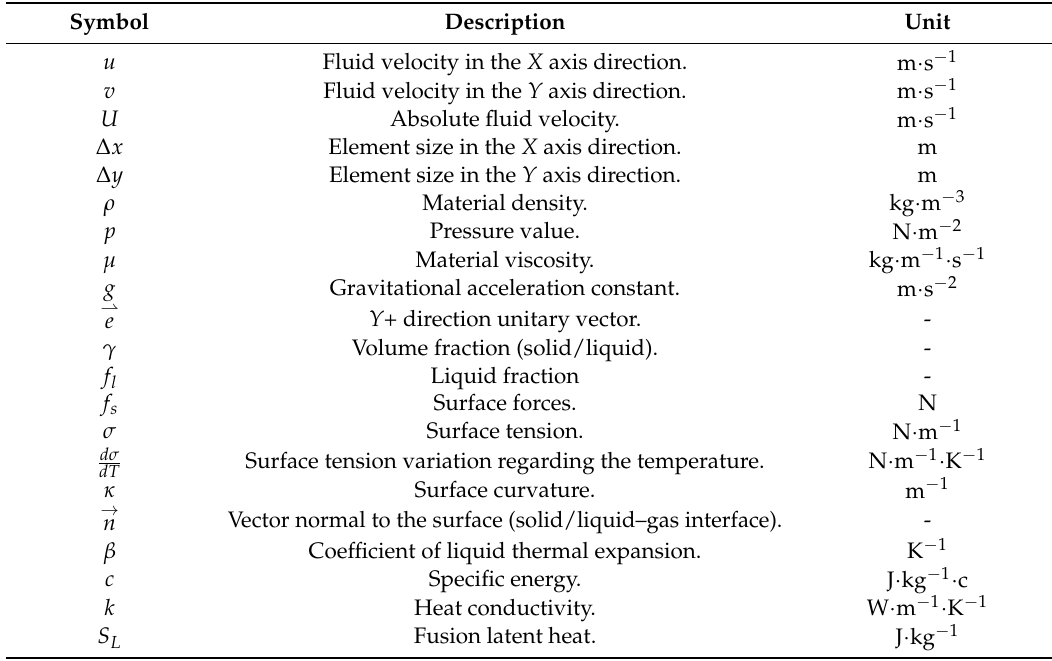
Table 1. Employed symbols and